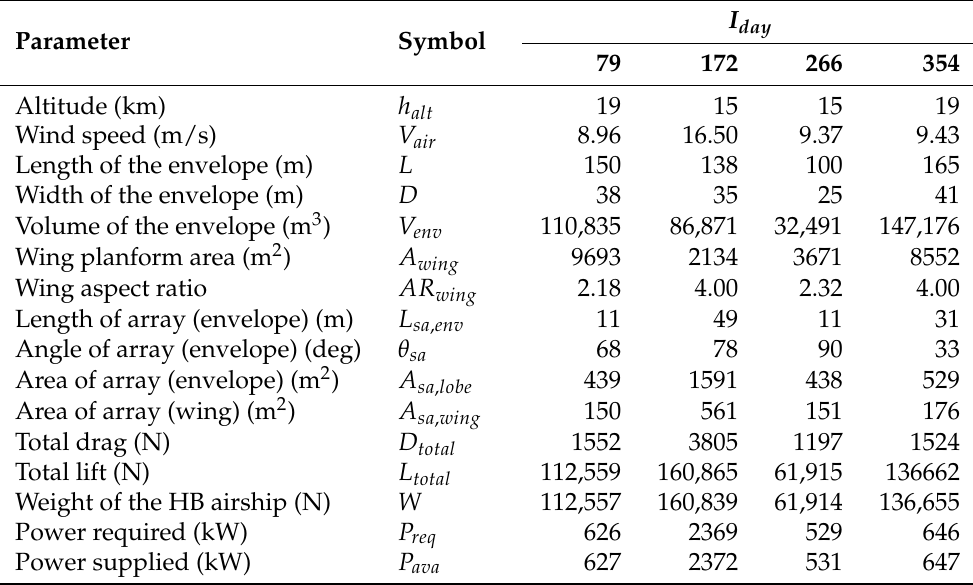
Figure 16. Optimum configurations—winged hybrid airship. Table 7. Key output